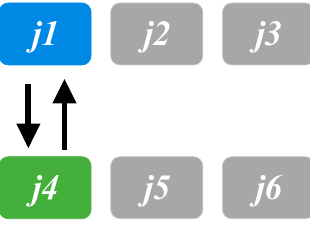
Figure 2. Single job switching.